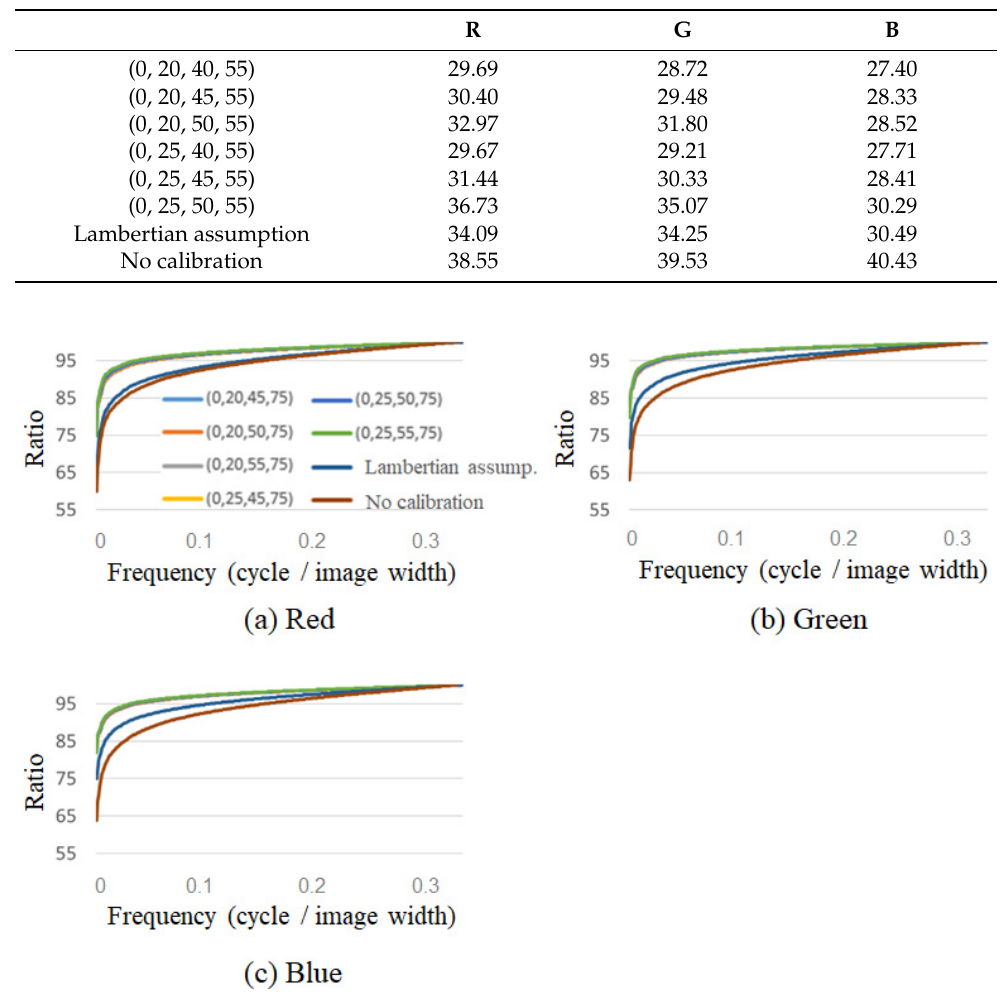
Table 3. Standard deviation of captured RGB values on the calibrated area (green projection onto encapsulated lens type).